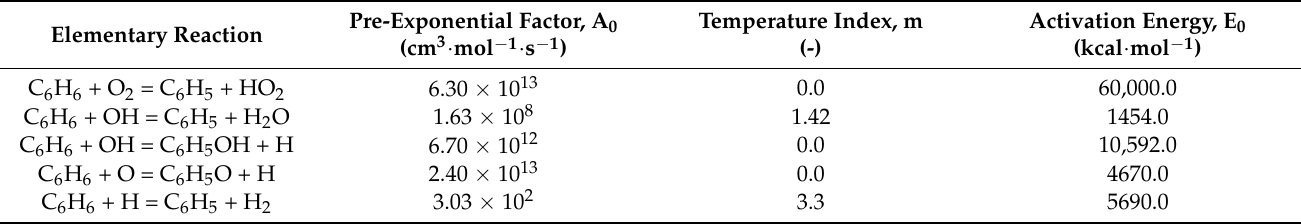
Table A1. Elementary reactions and chemical reaction kinetic parameters related to the C 6 H 6 [25].